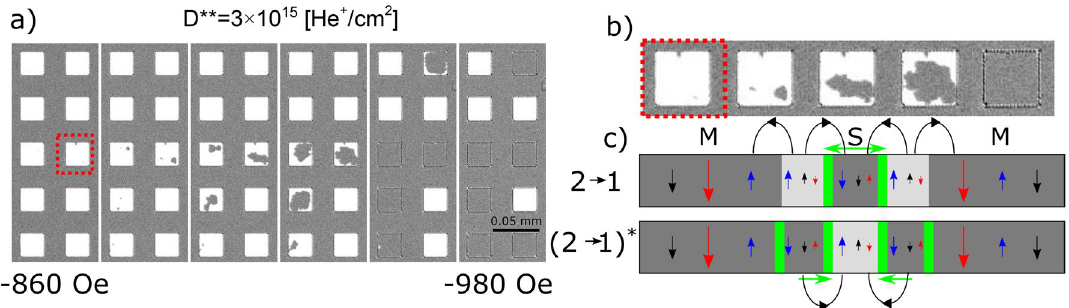
Figure 8. ( a ) P-MOKE microscopy images of the magnetization reversal of squares with a = 25 μm (sample B2) for the 2 → 1 transition and ( b ) close-up image of one representative square. ( c ) Schematic cross-section of the intermediate phase showing the effective magnetization, and the magnetization of the Co and Tb subsystems within the matrix (M) and the square (S) in two variants: (2 → 1) with the domain nucleation in the center of the square [consistent with the images of panel (a)], (2 → 1)* with the domain nucleation in the vicinity of the